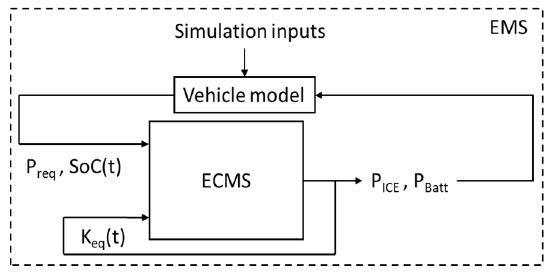
Figure 7. Simplified diagram of input and output states for ECMS.